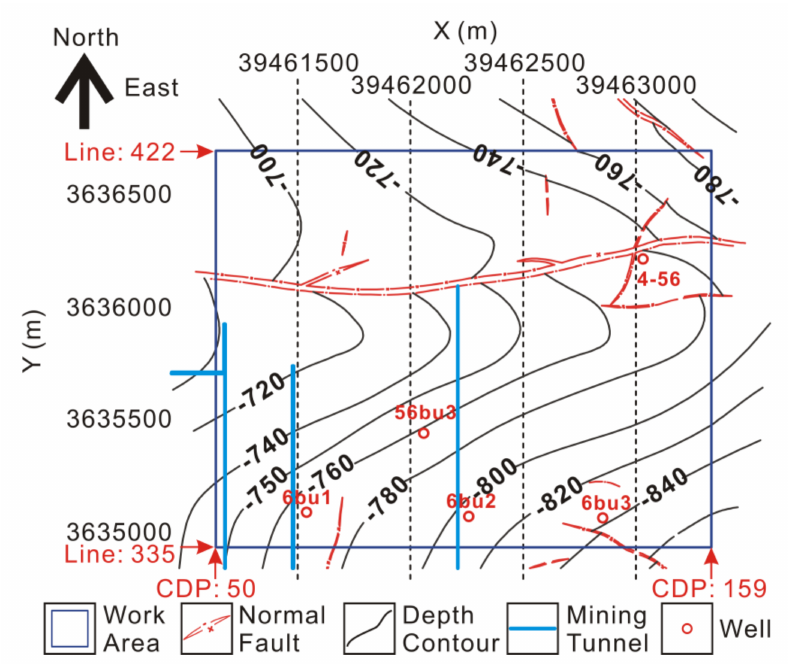
Figure 8. Structural map of the floor of coal seam 13-1 in the work area, adapted from Huainan Coal Mining